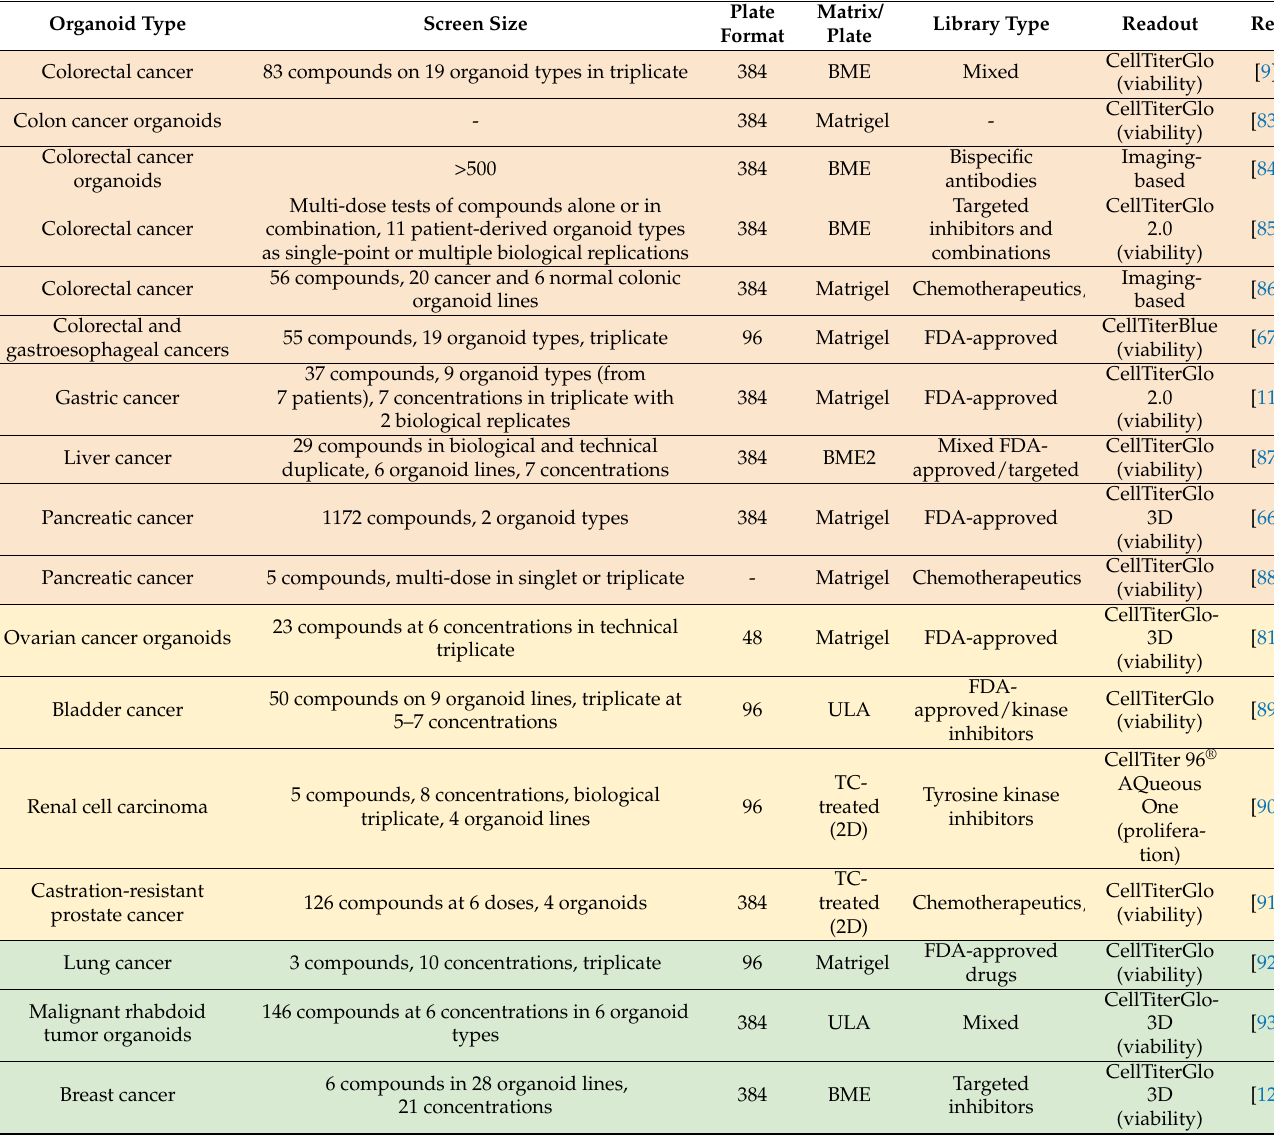
Table 1. Drug response tests and screens with human tumor organoids. ULA, ultra-low-attachment surface; FDA, federal drug administration; BME, (Cultrex) basement membrane extract; TC, tissue- culture. Coloring per type: Gastrointestinal, Genitourinary,